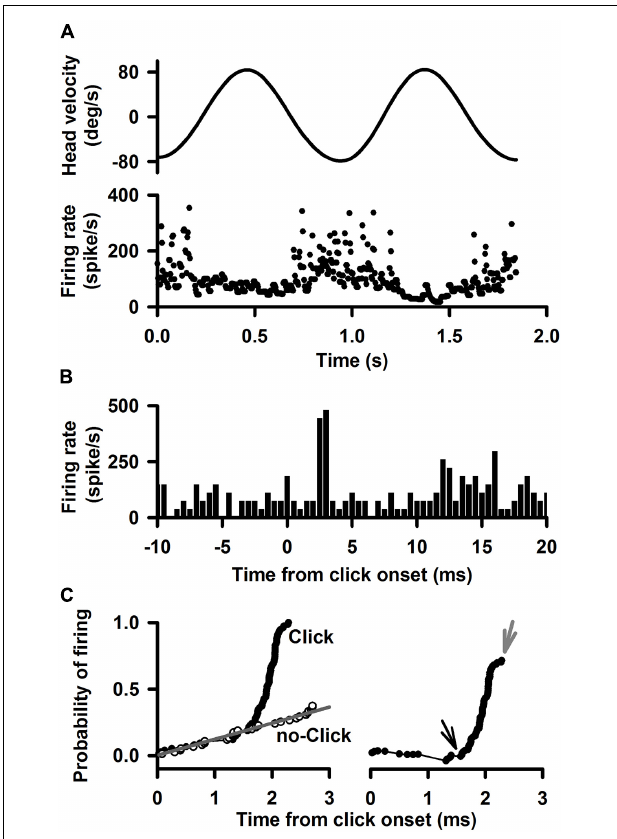
FIGURE 1 | A representative Type I neuron’s responses to clicks (0.1 ms, rarefaction, 50–80 dB SL, 0 dB is referred to the threshold of the ABR) delivered to the ipsilateral ear. (A) Upper trace: head velocity. Lower trace: firing rate of the neuron in response to 1 Hz horizontal rotation. (B) Peristimulus histograms of click-evoked responses at 80 dB SL. Bin size is 0.5 ms. (C) Quantitative measurement of the time course of the click-evoked excitatory response. Left panel probability of evoking a spike. The black curve labeled “click” plots the probability that the neuron fired as a function of time after click onset. The gray curve labeled “no click” plots the probability that the neuron fired as a function of time during spontaneous discharging. Right panel Probability of evoking a spike as a function of time, obtained by subtracting the regression line (no-click, gray) in the upper panel from the data for “click” case. Amplitude of evoked-response is defined by cumulative probability of evoking a spike (CPE), which is estimated as peak probability (gray arrow) minus the baseline probability (black arrow). Latency of click-evoked response is defined as the onset of the sharp increase in firing probability (black arrow).